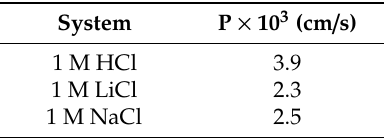
Table 5. Gold(III) transport varying the chloride source in the feed solution.